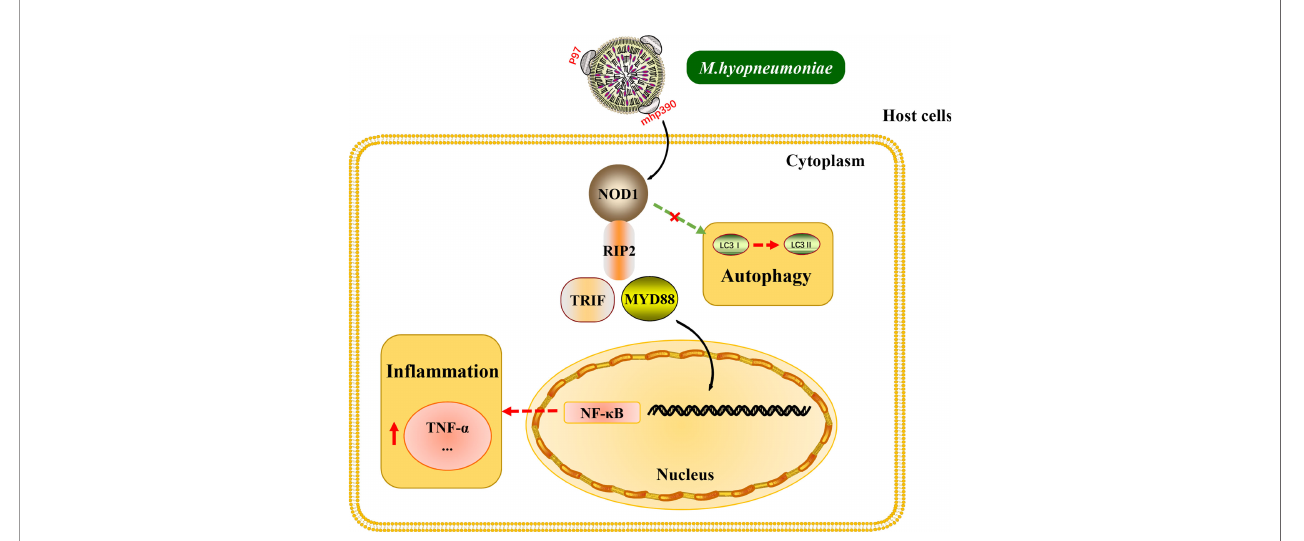
FIGURE 7 | Schematic representation of the NOD1-RIP2 signaling pathway in M. hyopneumoniae invasion of alveolar